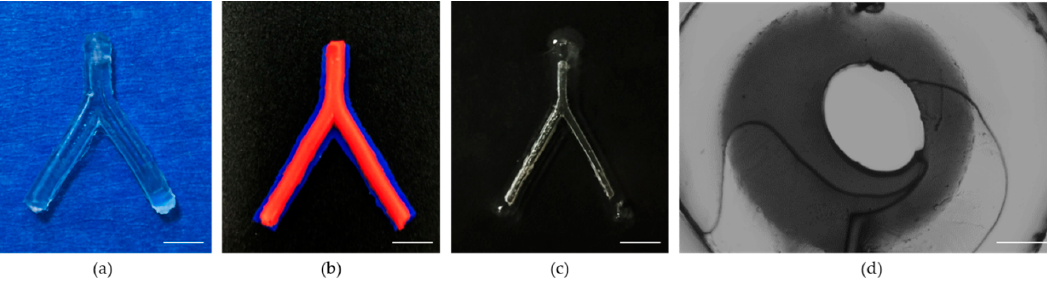
Figure 8. Morphology of the TEVG: ( a ) top view; ( b ) multilayered structure of the TEVG (blue: outermost layer of the structure; and red: middle layer of the structure); ( c ) inner channel of the construct after being submerged in water. (Scale bars: 5 mm); and ( d ) section view of the TEVG (Scale bar: 500 μ m).